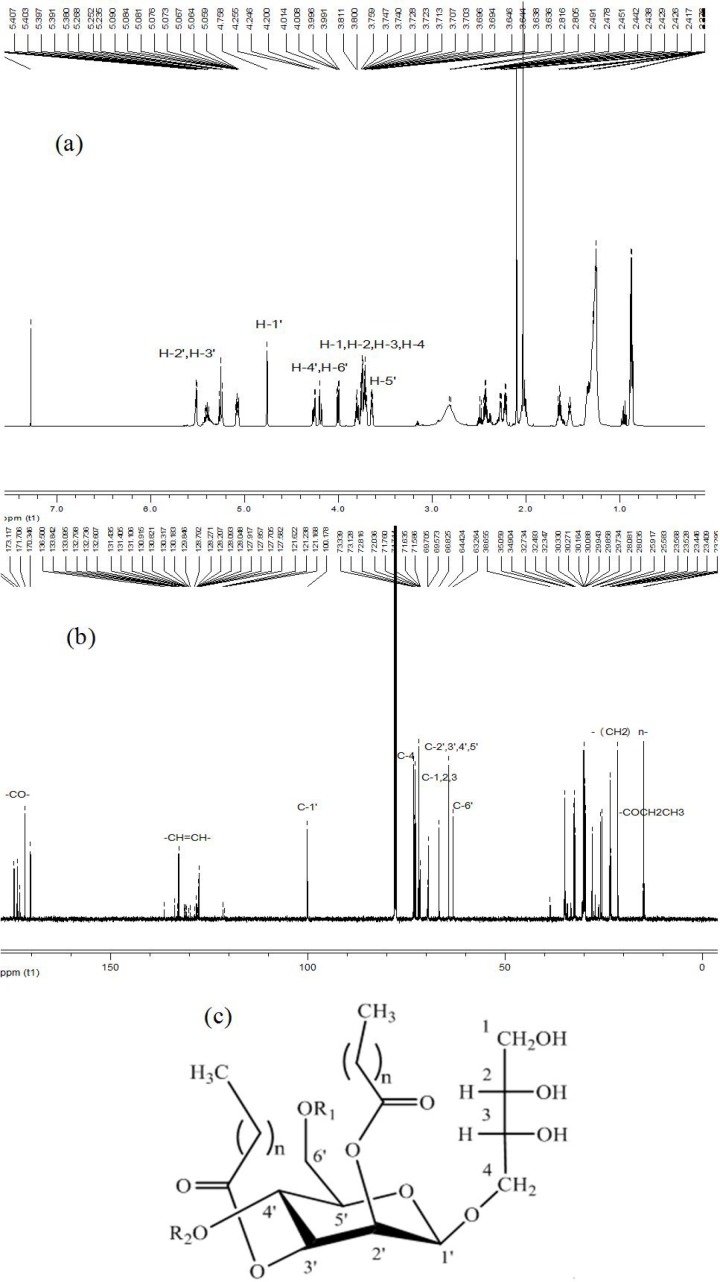
1H NMR spectrum and 13C NMR spectrum of MEL-A.(a), 1H signals at 0~7.0 ppm and (b), 13C signals at 0~180.0 ppm. (c), Structure of MELs, MEL-A: R1 = R2 = Ac; MEL-B: R1 = Ac, R2 = H; MEL-C: R1 = H, R2 = Ac; MEL-D: R1 = R2 = H, n = 6–16.